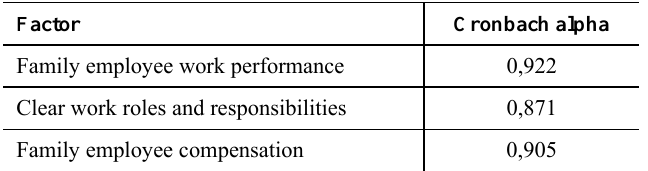
Table 3: Reliability of the constructs measuring family employee work performance and compensation in family